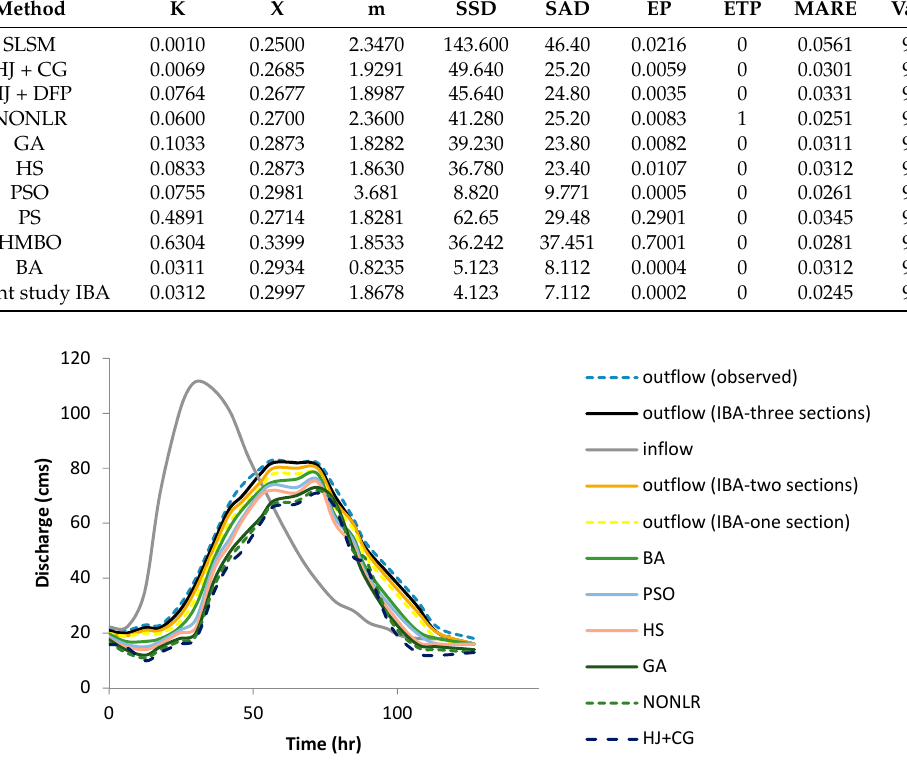
Figure 3. The simulated Hydrographs for Wilson flood using different methods.